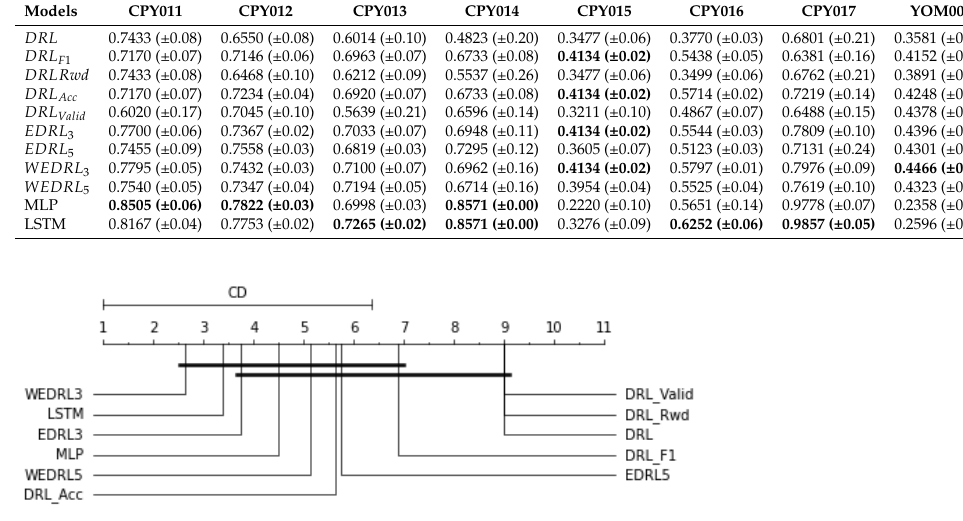
Figure 9. Critical difference